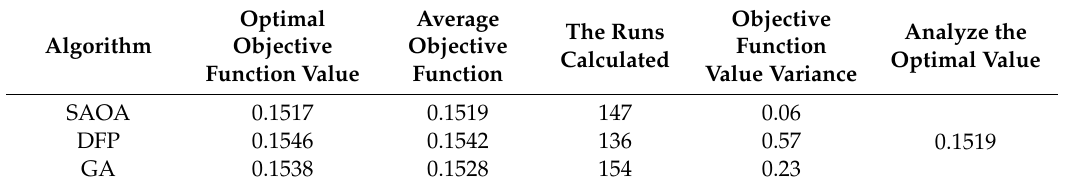
Table 1. Comparison of the results of the three algorithms (%).